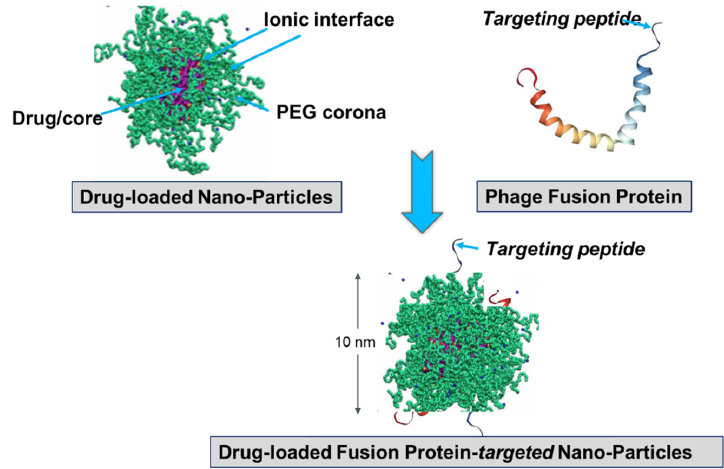
Figure 8. Preparation of landscape-phage pVIII-targeted paclitaxel-loaded PEGylated lipid micelle particles [94,98]. Equilibrated micelles contain three distinctive regions: lipid hydrophobic core, ionic interface, and poly(ethylene glycol) (PEG) corona. The fusion pVIII spans the core and displays the foreign peptide in PEG corona. The insoluble in water drug (paclitaxel) is solubilized in the core. Image of PEG-ylated sterically stabilized micelles is adopted from [104]. The model of pVIII phage protein in lipid environment is adapted from [105].